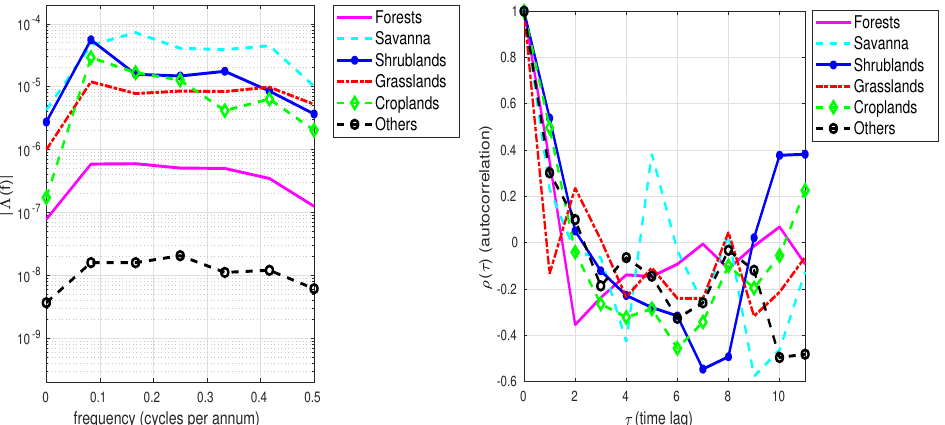
Figure 7. Graphs of the power spectrum as a function of frequency and autocorrelation versus lag time applied to the time series of the proportion of the burnt area for different vegetation types over all sub-Saharan Africa.